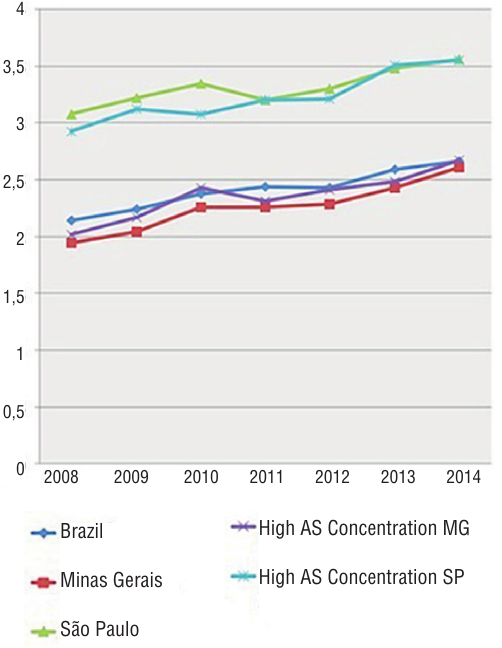
figure 3 - Mortality due to bladder neoplasia in Brazil, in the states of Minas Gerais and São paulo, and their respective areas with the highest concentrations of arsenic.